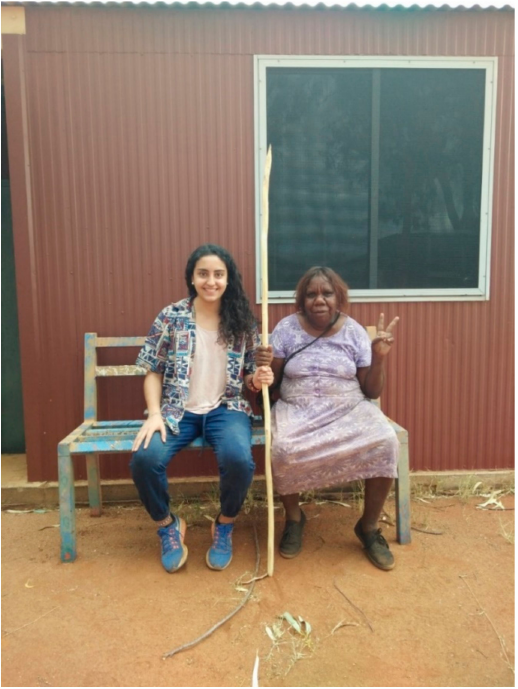
Figure 1. Yessica Trapero and Kelly Dixon at the back of the art centre holding the spear that they made together in September 2017, photo by Chrischona Schmidt / Ikuntji